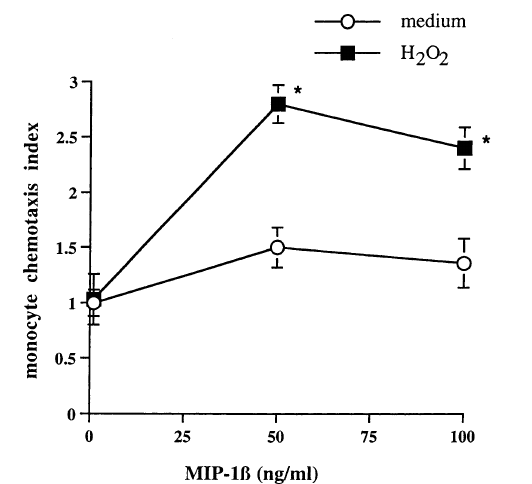
FIG. 8. Effect of H 2 O 2 on monocyte chemotaxis. Monocytes were treated with either medium or 200 m M of H 2 O 2 for 4 h in serum-free medium. The medium was then replaced by new medium and the cells were incubated for 16 h at 37 8 C. Chemotactic activity was measured in response to MIP-1 b using a modified Boyden chamber chemotaxis assay. The figure illustrates the means 9 / SEM of triplicate determina- tions of one representative experiment.